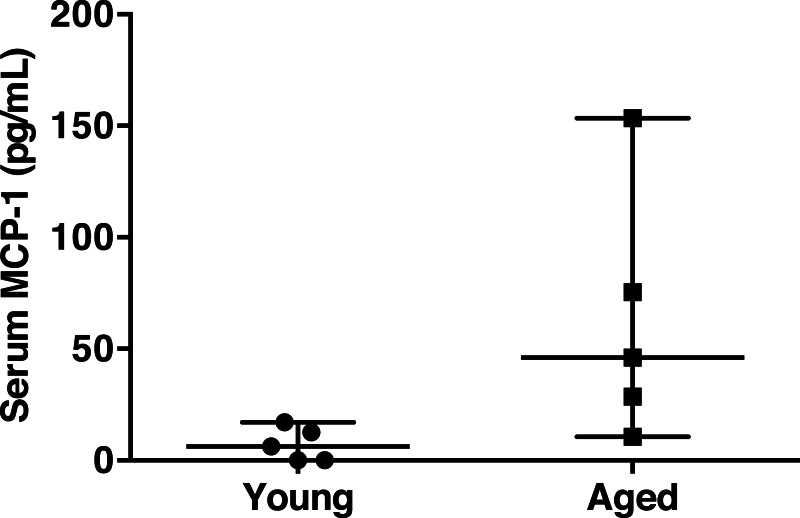
Serum MCP-1 distribution of aged and young mice.Mean serum MCP-1 levels in aged mice are significantly higher than in young mice (62.8 ± 25.0 versus 7.2 ± 3.4 pg/mL, respectively, Wilcoxon-test p = 0.036). Points represent individual mice. Lines represent minimum, median, and maximum values.